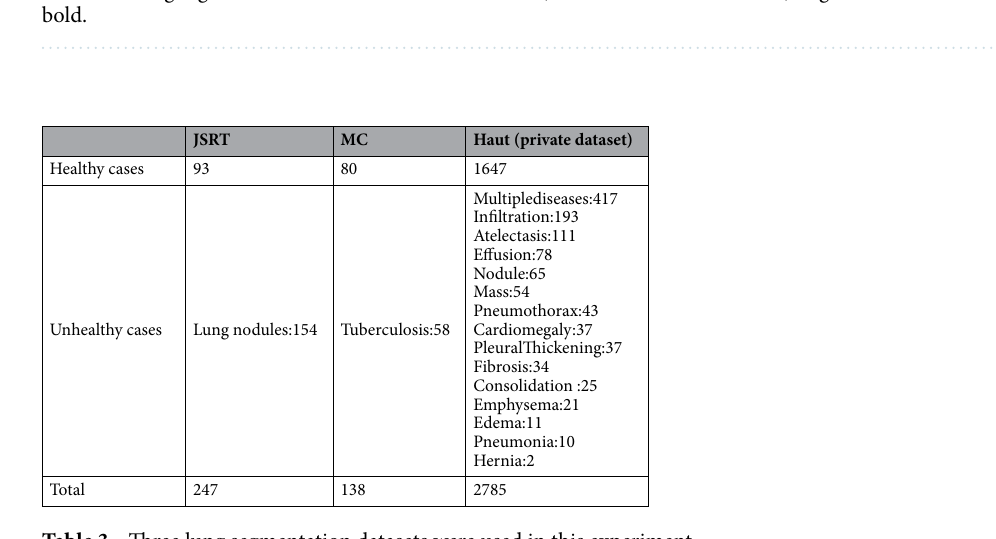
Table 3. Three lung segmentation datasets were used in this